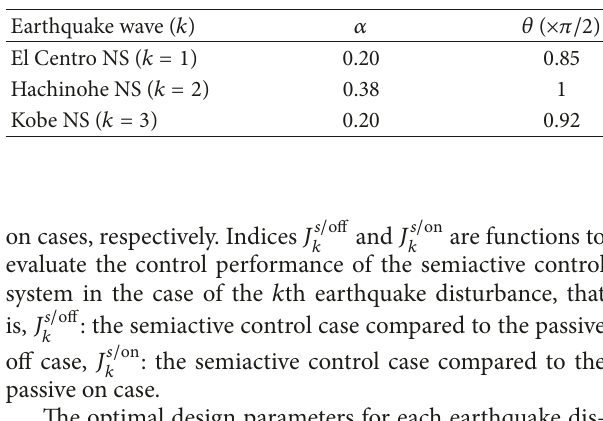
Table 2: Optimal design parameters of the semiactive control for each earthquake